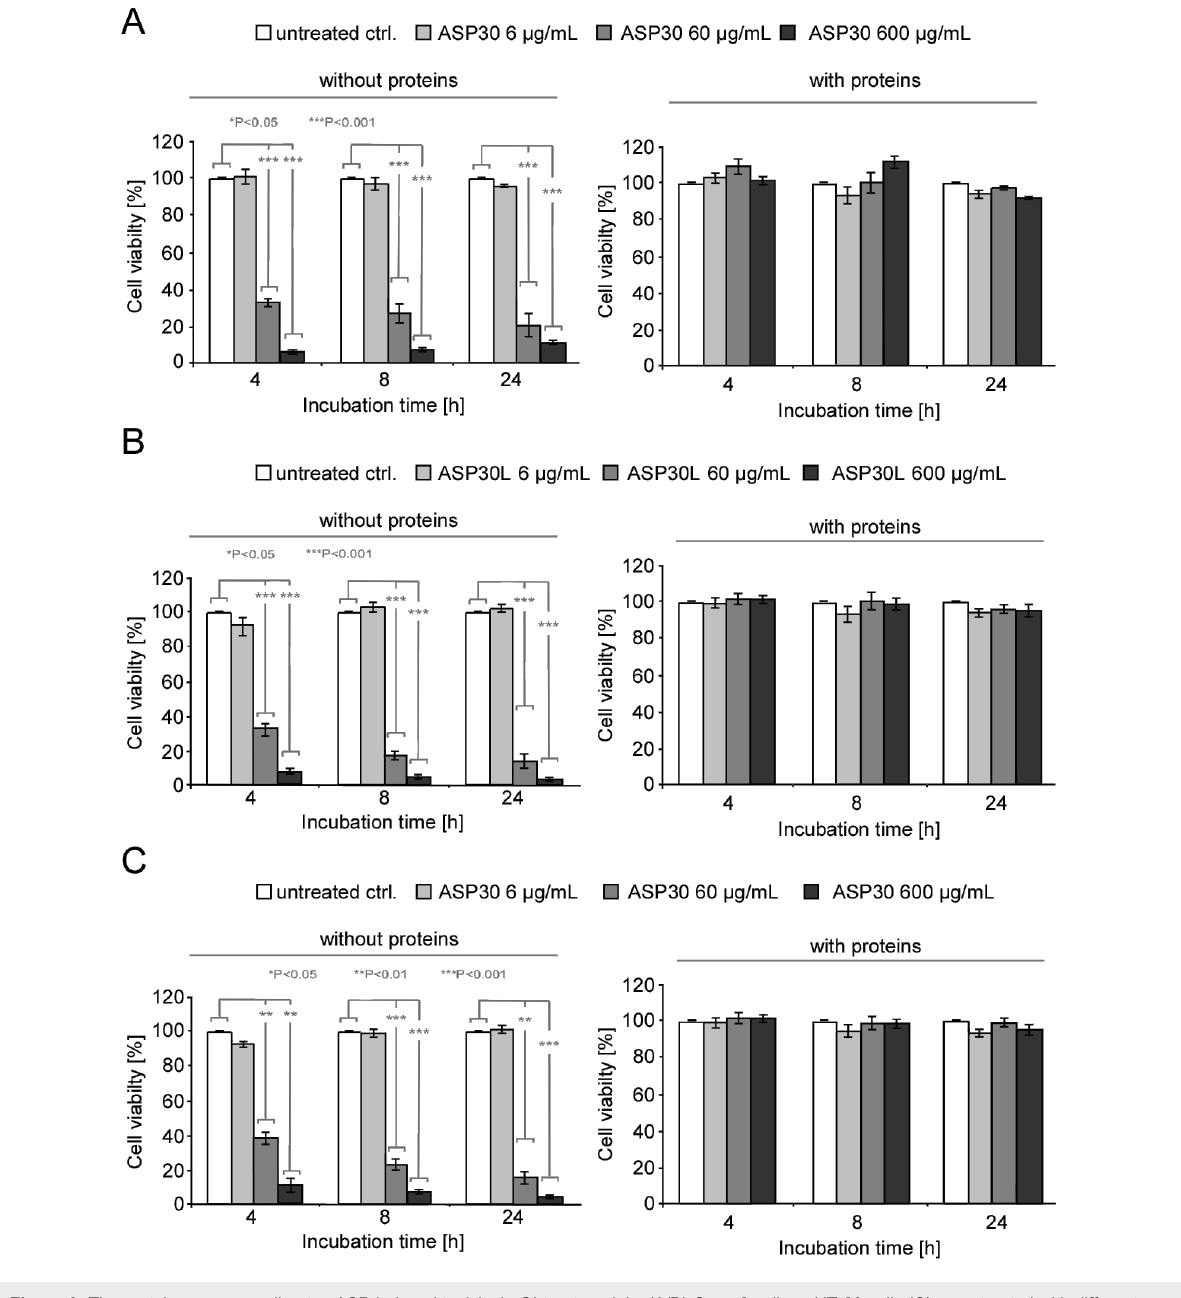
Figure 6: The protein corona ameliorates ASP-induced toxicity in GI-tract models. (A/B) Caco-2 cells or HT-29 cells (C) were treated with different concentrations (6 to 600 µg/mL) of ASP30 (A/C) or ASP30L (B) in serum-free or serum-containing (10% human plasma) DMEM. The cell viability was analyzed for the indicated time points by using the MTT assay. Data are depicted as percentage compared to untreated control cells, which was set to 100% vitality. Results are shown as mean ± SD ( n = 3). * P < 0.05, ** P < 0.01 and *** P <